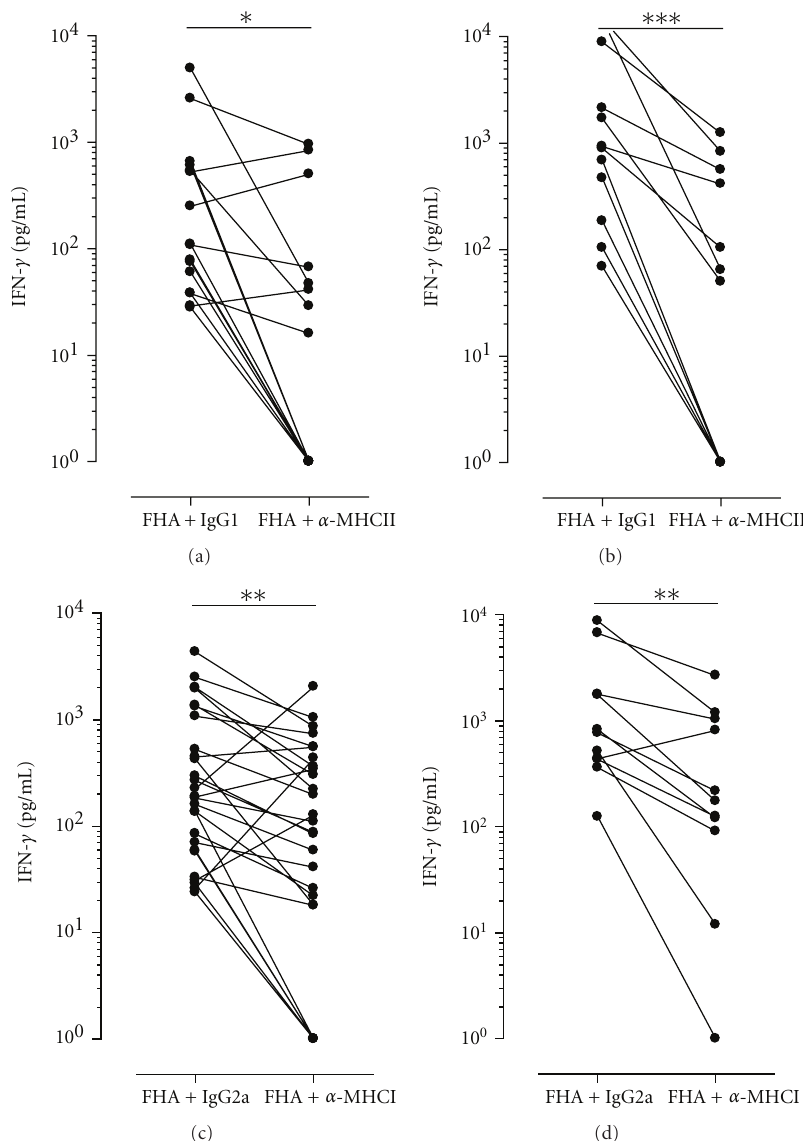
Figure 1: E ff ect of blocking anti-MHC class I and anti-MHC class II antibodies on the FHA-specific IFN- γ production. Isolated PBMC were stimulated in vitro for 72h with 1 μ g/mL FHA in the presence or absence of blocking anti-MHC-II (a) and (b) or anti-MHC-I (c) and (d) antibodies or in the presence or absence of control isotypes. Unstimulated cells were tested as control. IFN- γ concentrations were measured in the cell culture supernatants and values obtained for unstimulated cells were subtracted from those obtained for stimulated cells. Circles represent the individual IFN- γ concentrations obtained after stimulation with FHA in the presence of anti-MHC antibodies or control isotypes. Results obtained for the same samples are linked. ∗ P < 0 . 05; ∗∗ P < 0 . 001; ∗∗∗ P < 0 .